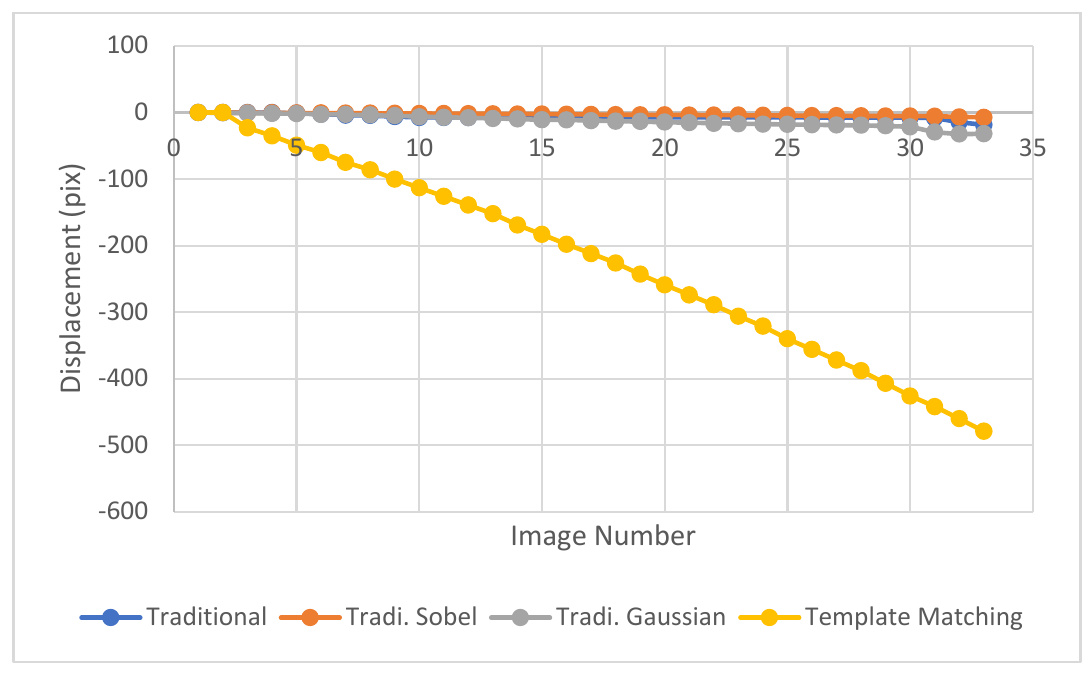
Figure 7. Displacement of a free-falling aggregate obtained using the 1st and 2nd derivative LK optical flow, compared with the displacement obtained using the template matching method.